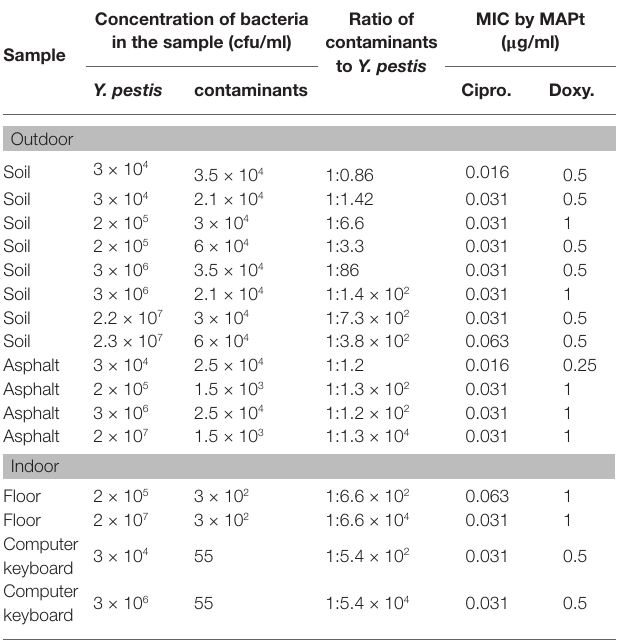
TABLE 2 | MIC values obtained by MAPt for Y. pestis -spiked environmental samples. Concentration of bacteria in the sample (cfu/ml) Sample